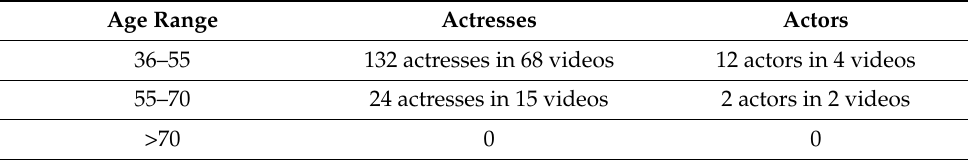
Table 3. Number of actresses and actors and videos in which they appear grouped by ages. Table 3. Cont.